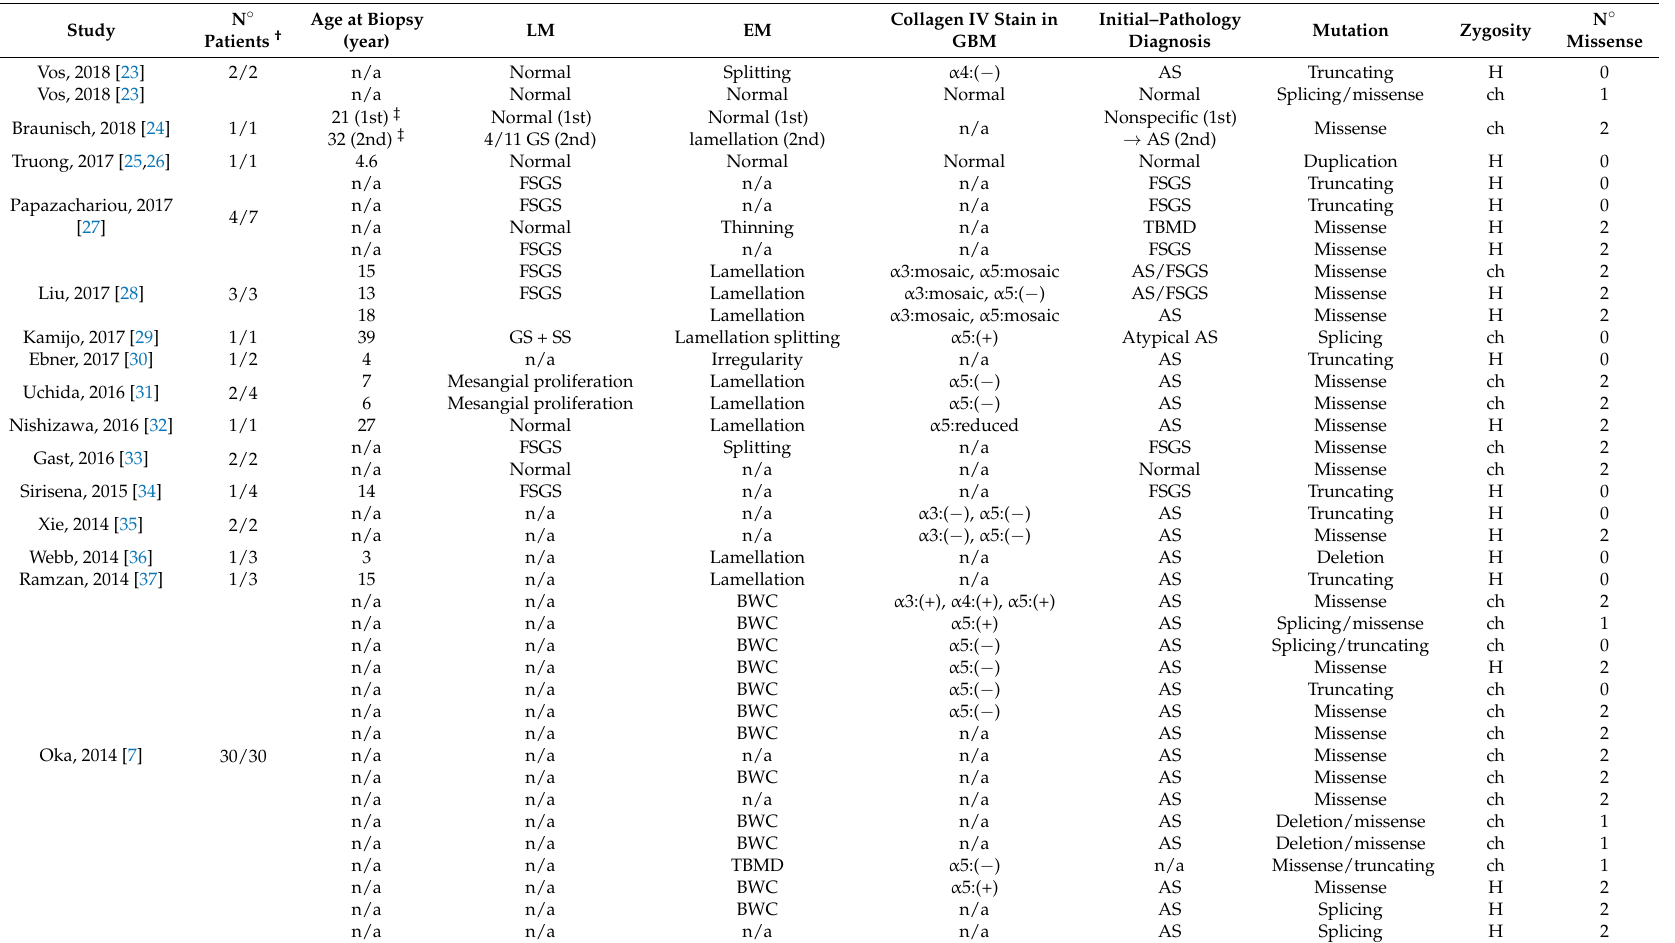
Table 3. Pathology profiles of individual patient data with